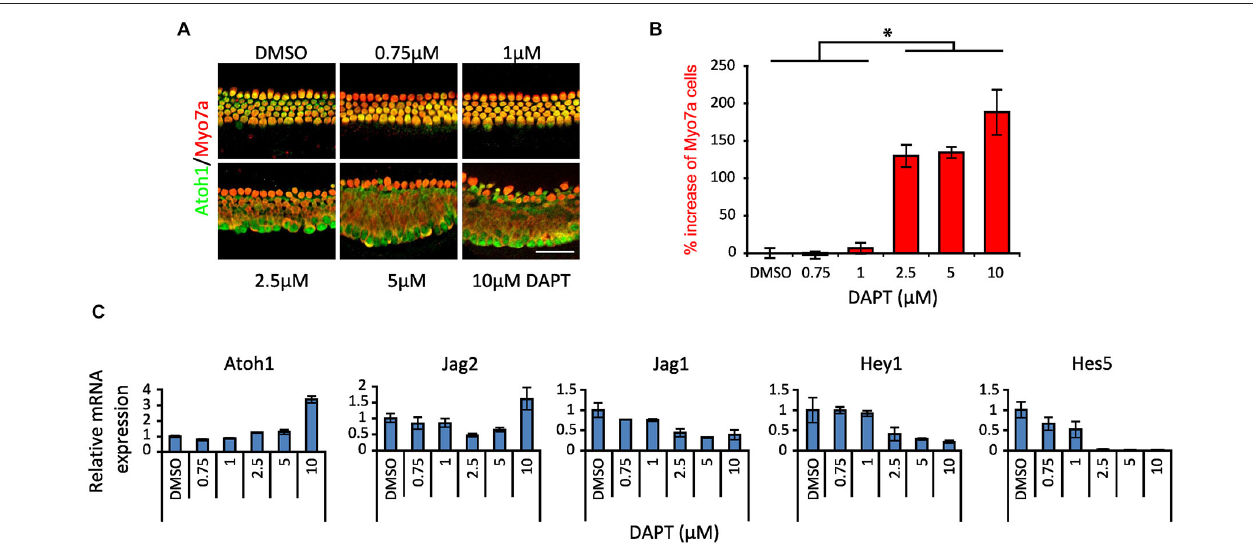
N = 4. * p = 0.030 (Mann-Whitney pairwise comparisons). Error bars: SEM. (C) mRNA amount of hair cell, supporting cell and Notch pathway genes obtained by QPCR in whole cochlear explants from P0 Atoh1 GFP transgenic reporter mice treated with DAPT compared to DMSO vehicle. N = 3. Error bars: SEM. Note that error bars are present for each condition but are very small in some cases.